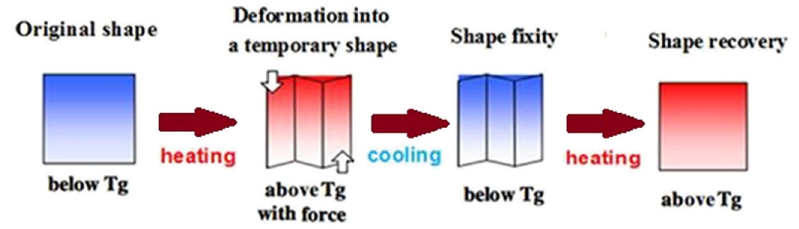
Figure 1: A schematic for the shape memory behavior